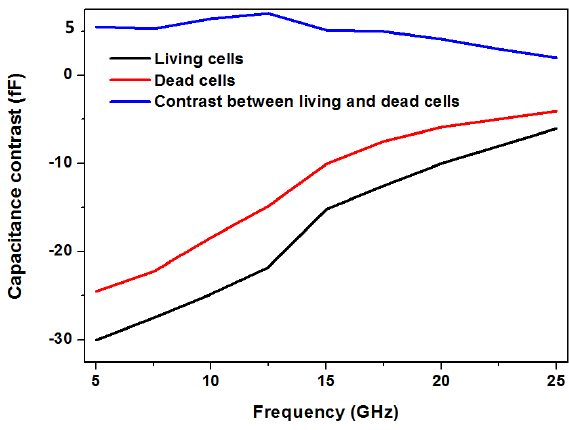
Figure 5. Distinction of living and dead cells using coplanar capacitive sensors [44].